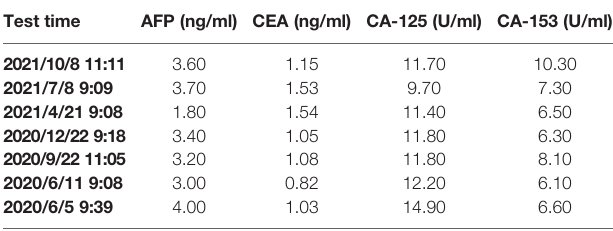
TABLE 1 | The concentration variations of the patient ’ s serum tumor markers during antihormonal therapy in immunoassay. Test time